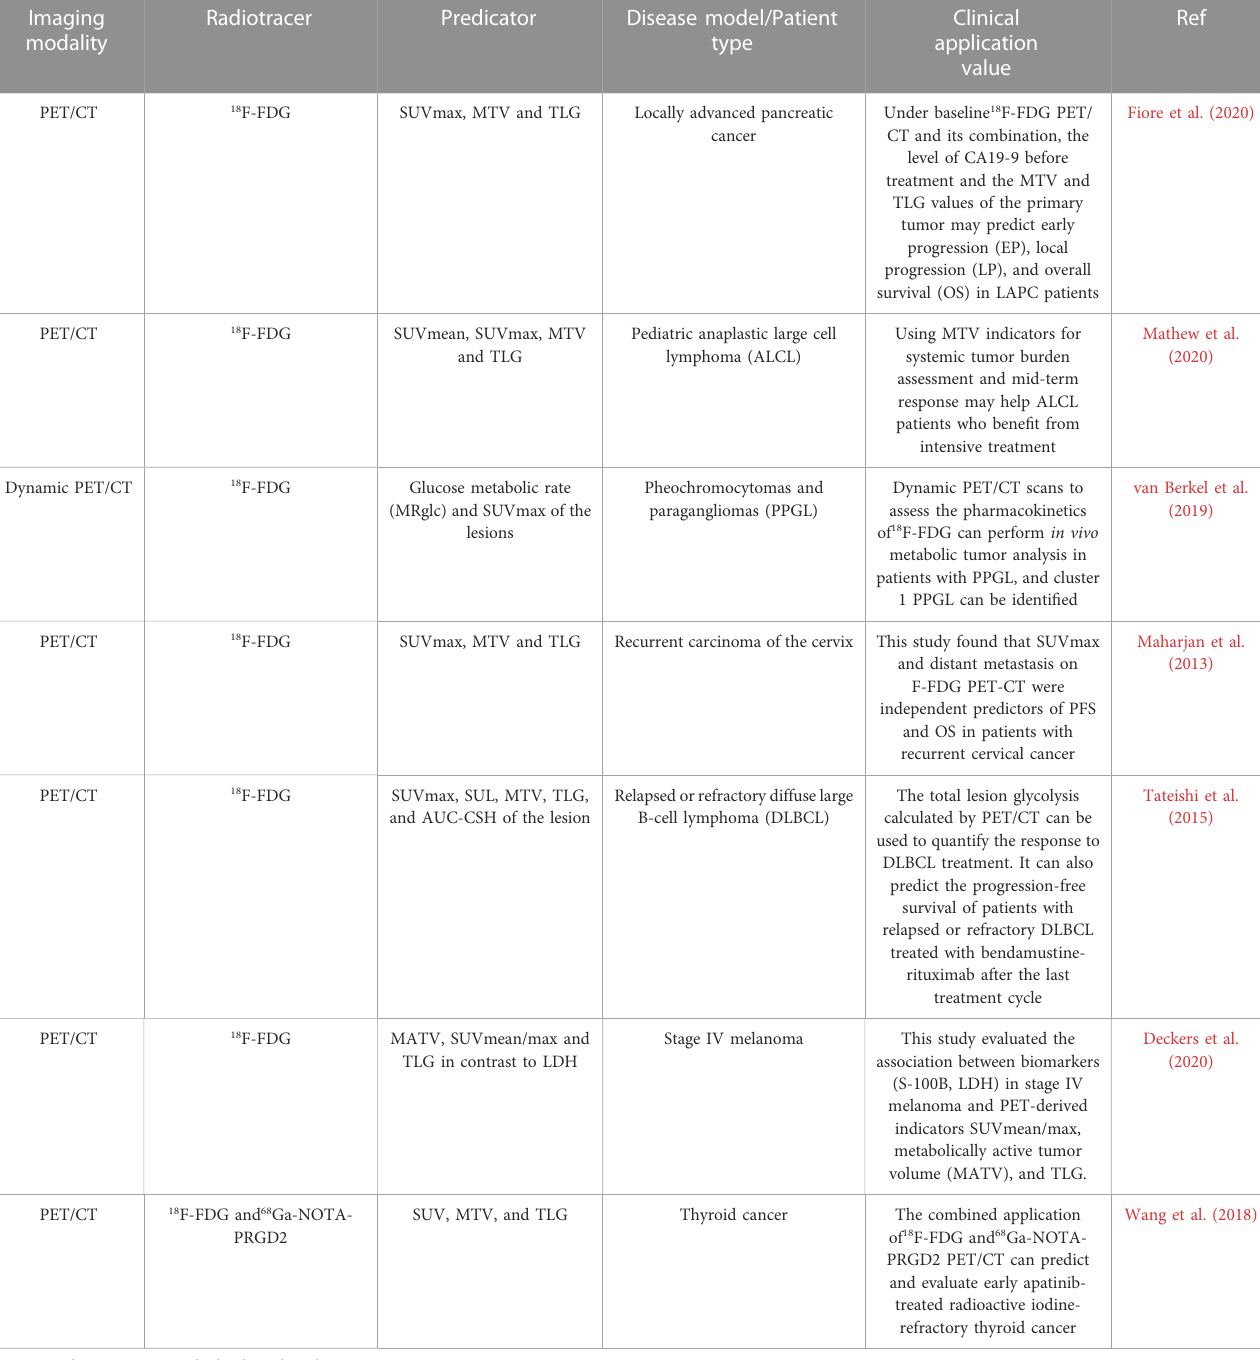
TABLE 2 ( Continued ) Clinical trials of glycolysis by FDG molecular